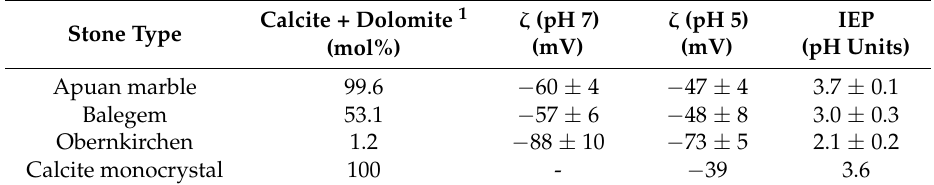
Table 4. Mineralogical composition (calcite + dolomite content, in mol%), values of ζ potential at pH 7 and 5 (in mV) and isoelectric points (IEP, in pH units) of untreated lithotypes.